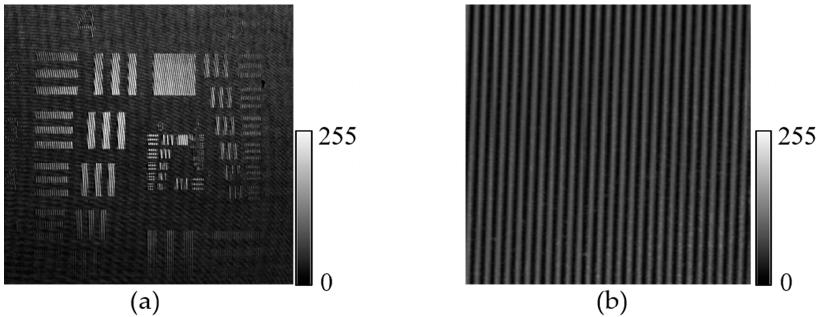
Figure 7. ( a ) One hologram recorded by Camera 1; ( b ) One interferogram recorded by Camera 2.